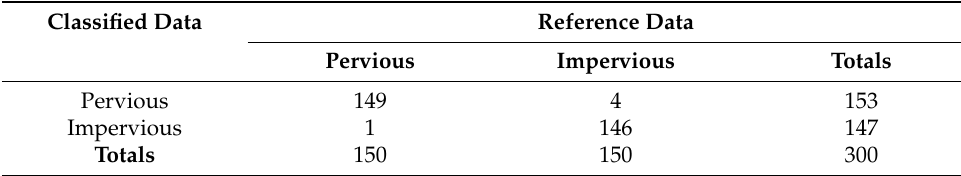
Table 4. 2018 Error (confusion) matrix.